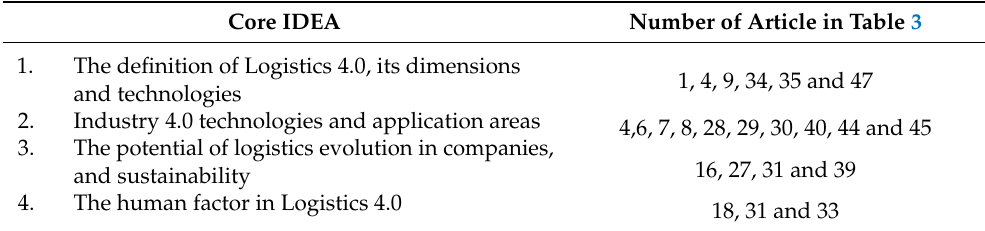
Table 4. The main ideas screened in the second set of data after the inclusion and exclusion criteria were considered [20–37].